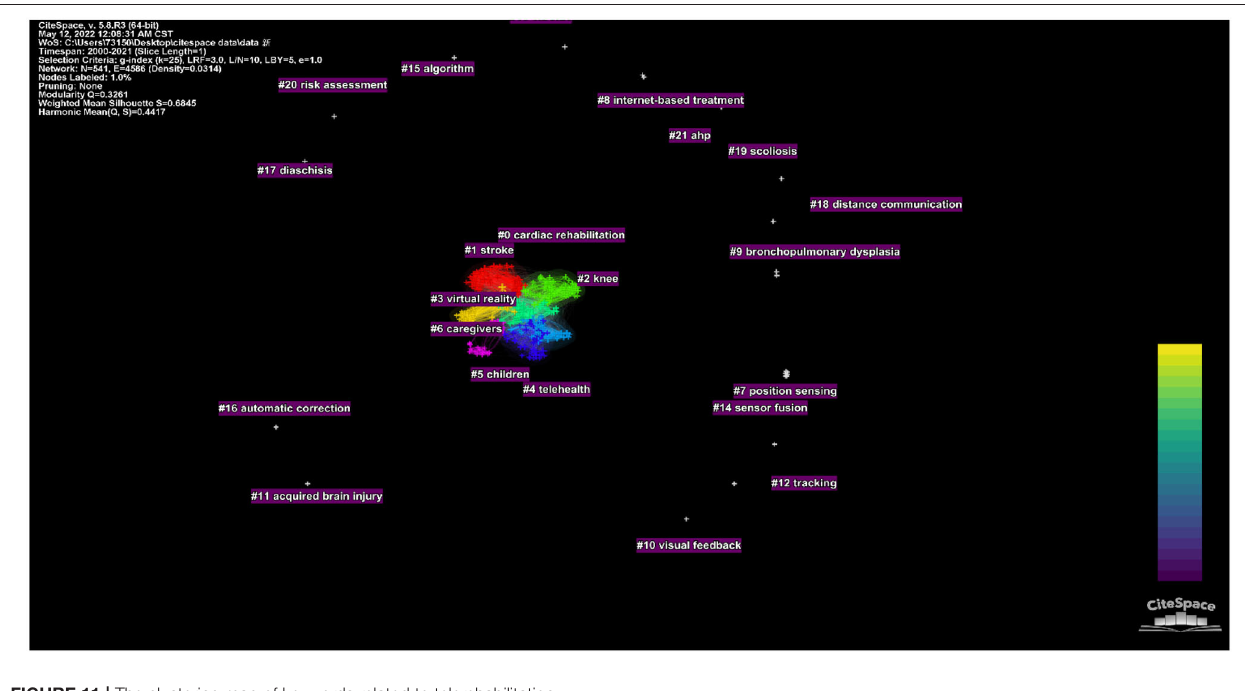
FIGURE 11 | The clustering map of keywords related to telerehabilitation.